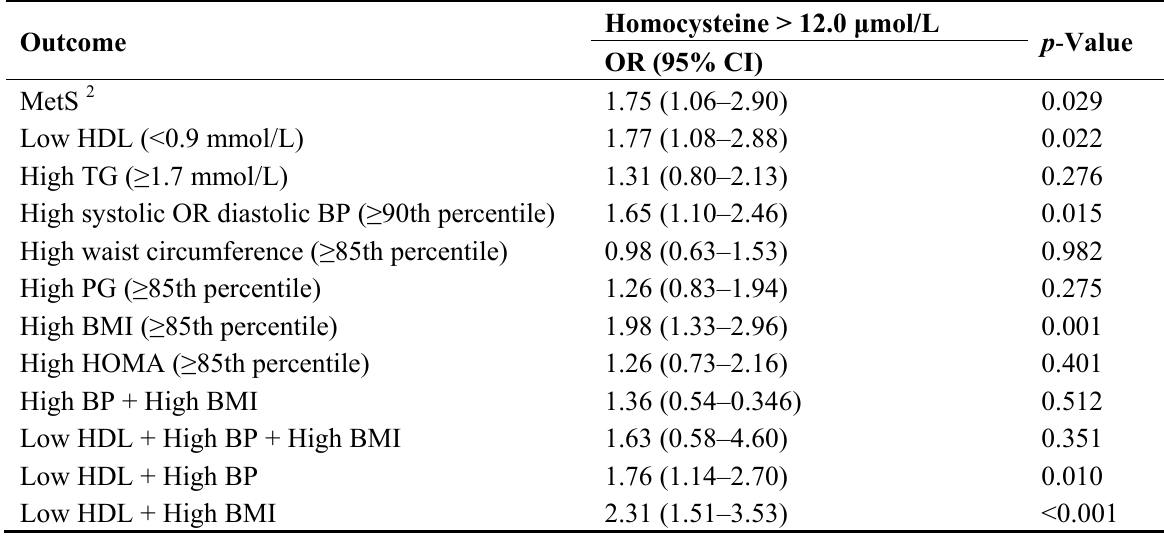
Table 3. Risk of MetS and its components in 6–8 years old children related to hyperhomocysteinemia ( n = 1000) 1